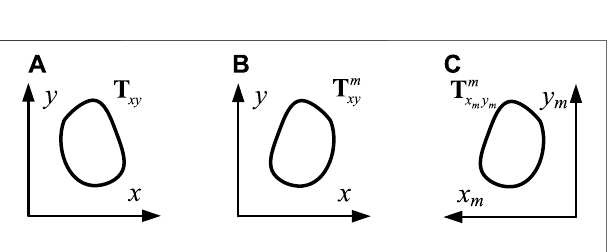
FIGURE 2 | (A) Arbitrary shape planar scatterer in the xy plane. (B) Y-axis mirrored scatterer in the xy plane. (C) Y-axis mirrored scatterer in the x m y m plane.